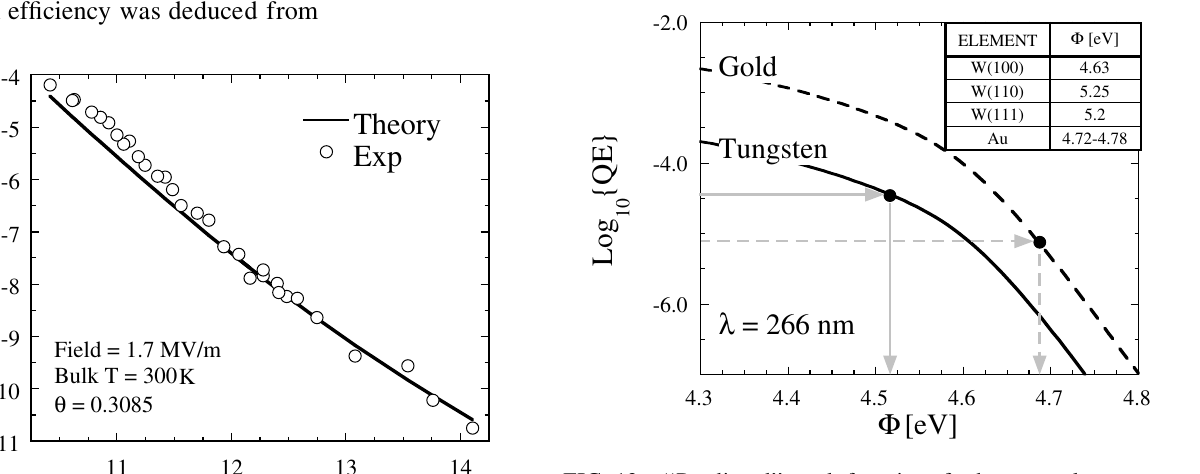
FIG. 12. ‘‘Predicted’’ work functions for bare metals tungsten and gold based on Table III parameters. The simulation code developed to treat the dispenser cathode can be used to predict FIG. 11. Same as Fig. 8, but on a Richardson plot in which work function based on quantum efficiency once an estimate of L (cid:1) n (cid:2) is available. The agreement between theory and experi- , where T is evaluated ln Q=T 2 is plotted versus 1 =T max max via Eq. (12), showing approximate linearity and indicating ment for several materials suggests the value of n is reasonably thermal-emission-like behavior.